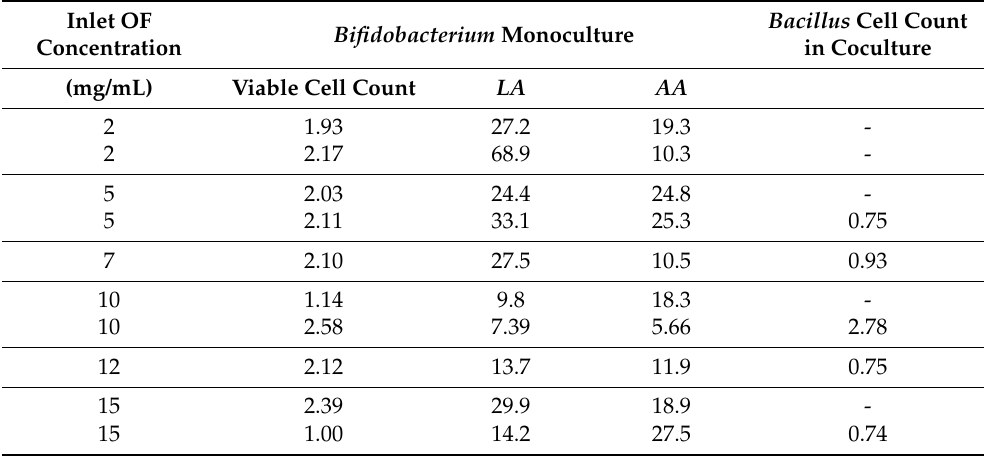
Bacillus Cell Count in Coculture